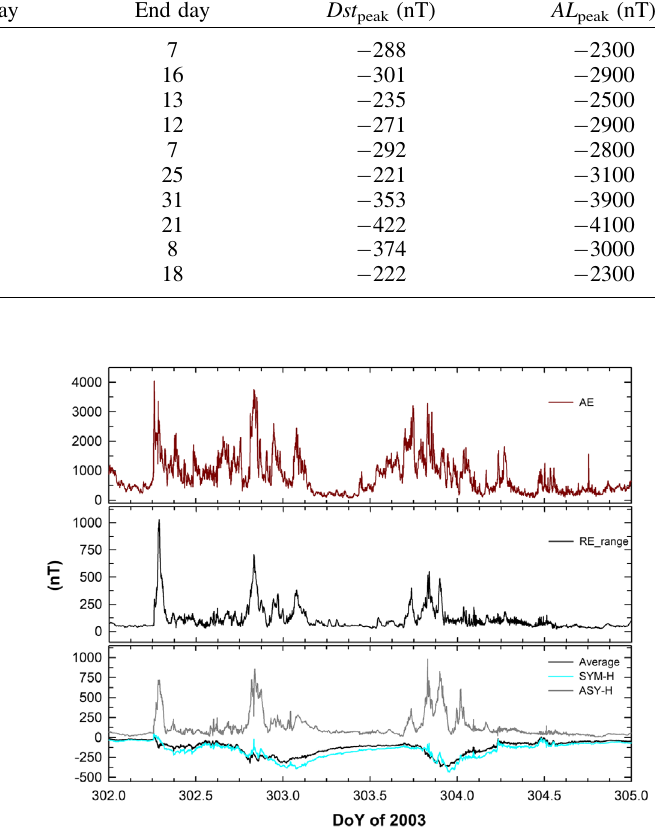
Fig. 5. Comparison between different indices for the event on 29 – 31 October 2003. Top panel: AE index; Second panel RE range ; Bottom panel: ASY-H (grey), SYM-H (cyan) and the average of the disturbance h H i i